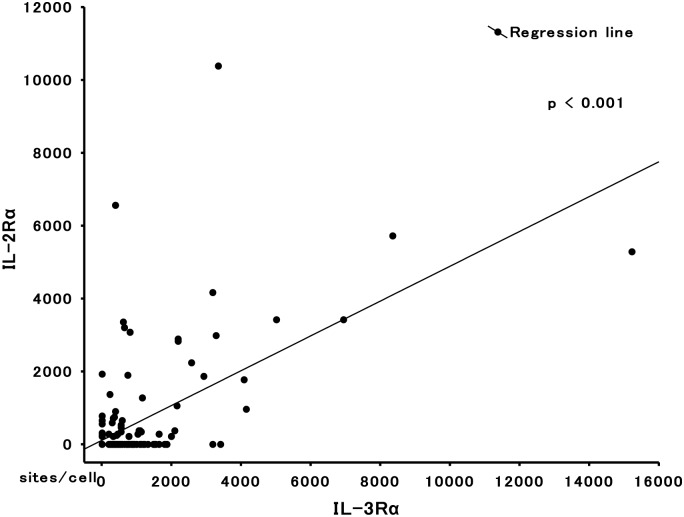
Correlation diagram for the expression levels of IL-2Rα and IL-3Rα.Data are shown for AML patients ≤60 years old.